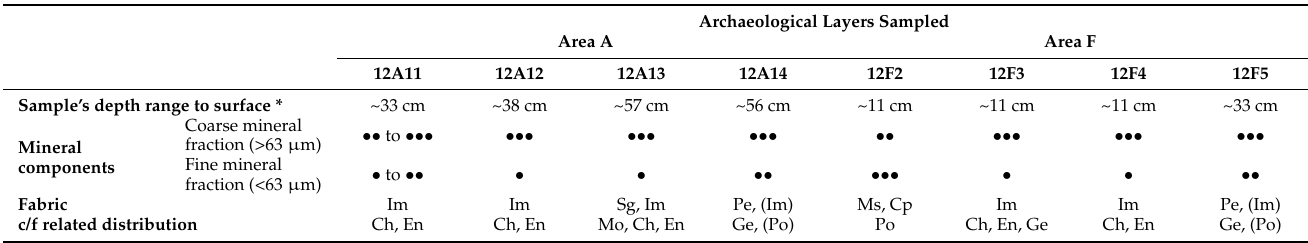
Table 6. Summary of micromorphological features of the sediment layers at the Fort Odanak site